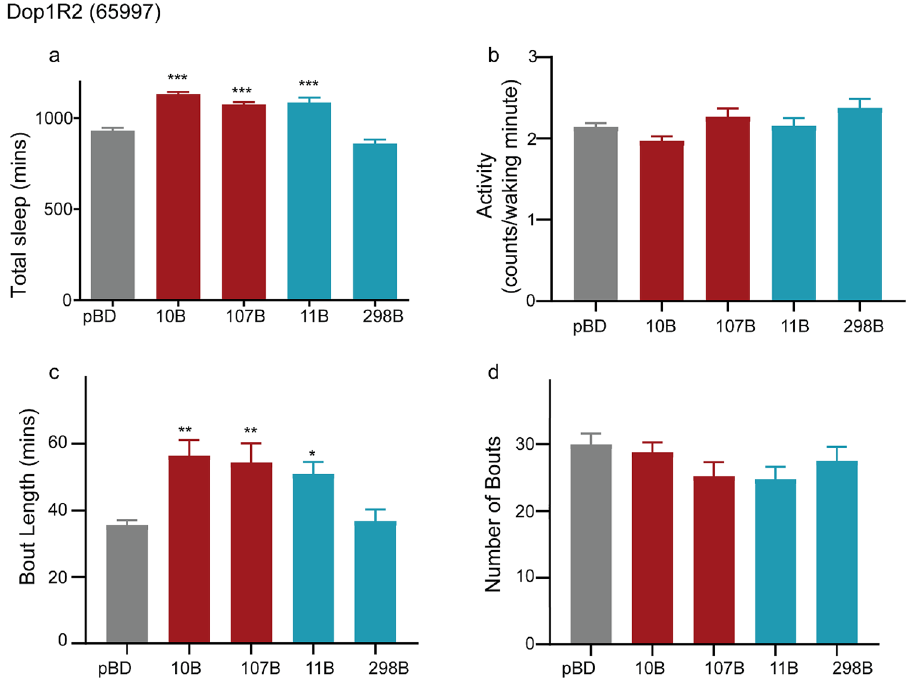
Figure 7. Knockdown of DopR2 in MB-KCs and MBONs of the sleep-regulating γ5 and β ′ 2 compartment increased sleep. ( a ) Total Sleep during a 24-h period in flies expressing UAS-DopR2 RNAi (65997) in MB-KCs (MB010B, MB107B: red), MBONs (MB011B, MB 298B: blue) and enhancerless/empty split-GAL4 pBD (control: grey). ( b ) Activity or average beam crossings/waking minute indicative of locomotor activity of flies of all tested genotypes. ( c , d ) Average bout length and number of bouts in flies expressing UAS-DopR2 RNAi (65997) in MB-KCs (MB010B, MB107B: red), MBONs (MB011B, MB298B: blue) and enhancerless/empty split- GAL4 pBD (control: grey). For each of the experimental groups tested we had 44–48 flies which represented 2 independent experimental trials, sample included 65997/pBD (48), 65997/MB010B (46), 65997/MB107B (47), 65997/MB011B (44), and 65997/MB298B (48). Data represents mean and SEM, * indicates p < 0.05, ** indicates p < 0.001 and *** indicates p < 0.0001. Statistical analysis was one-way ANOVA and Dunnett’s paired comparison with control for ( b , c , f , i ) and Kruskal–Wallis non-parametric one-way ANOVA and Dunn’s post-hoc correction for ( d , e , g , h